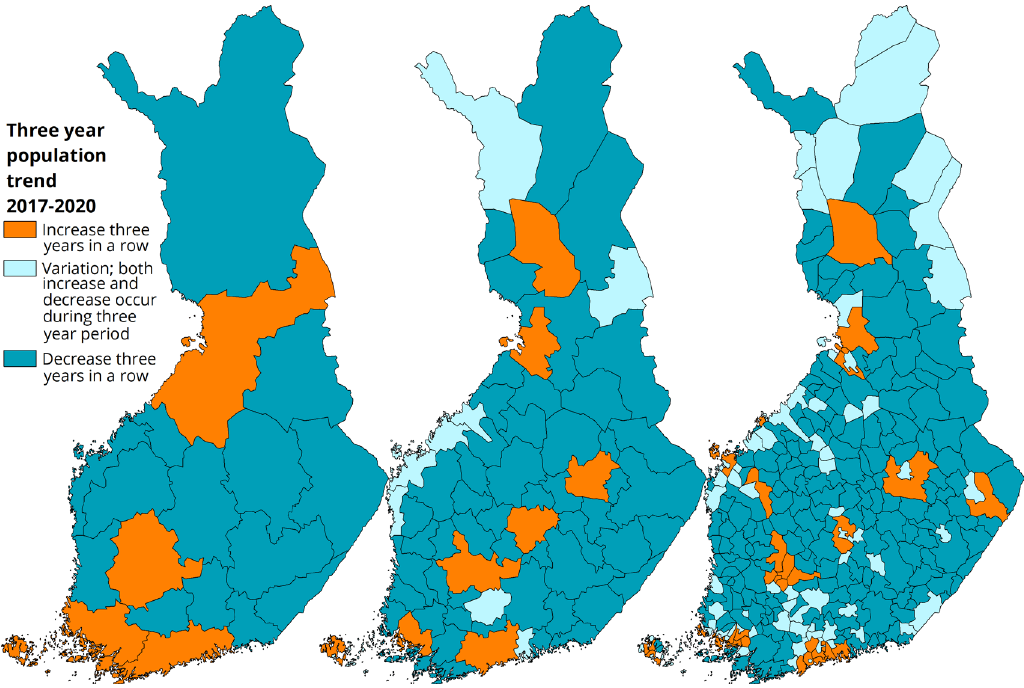
Fig. 4. Population changes of Finnish regions, 2018–2020.